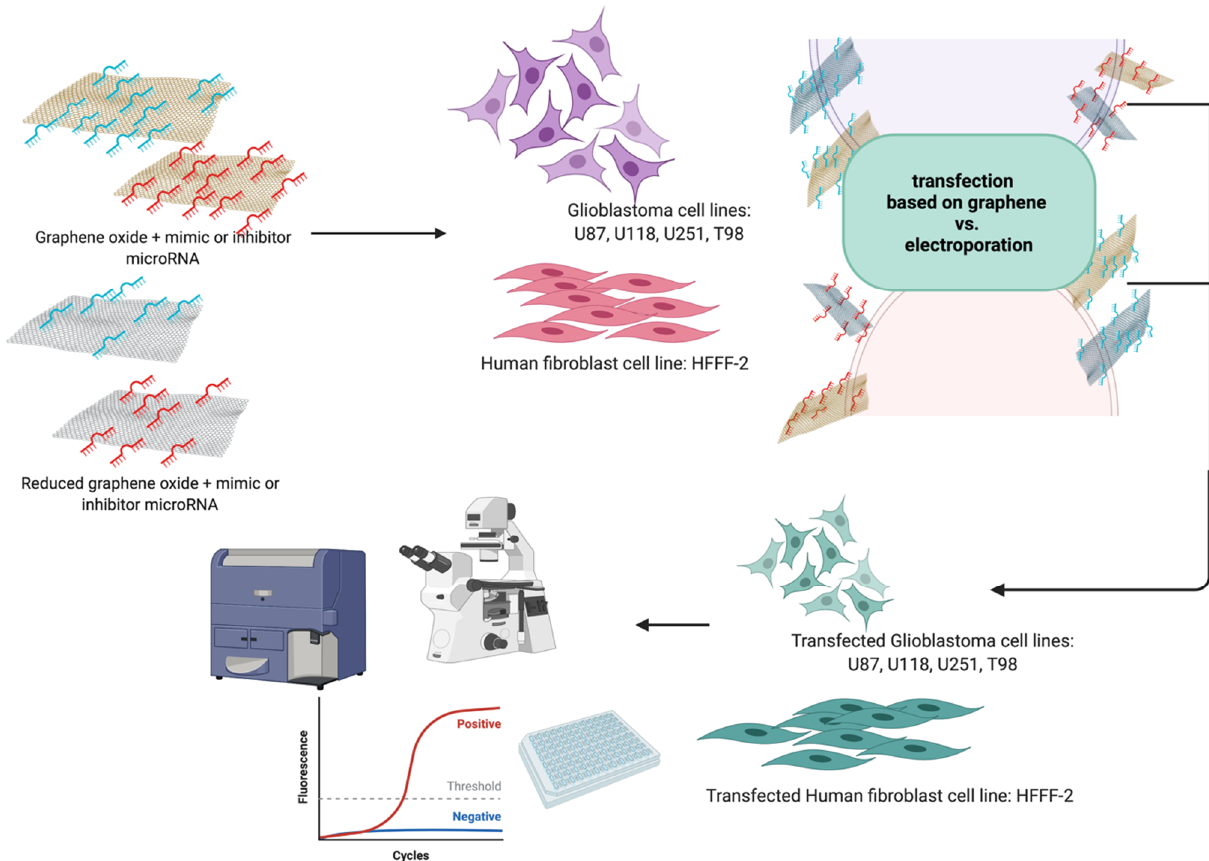
Figure 1. Graphical presentation of work.